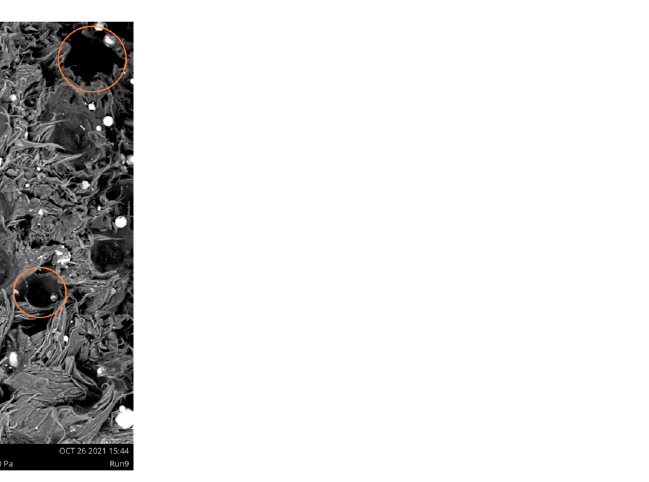
Figure 8. SEM-analysis of the air voids present in the compression moulded bricks of Sample 9, indicated in orange.